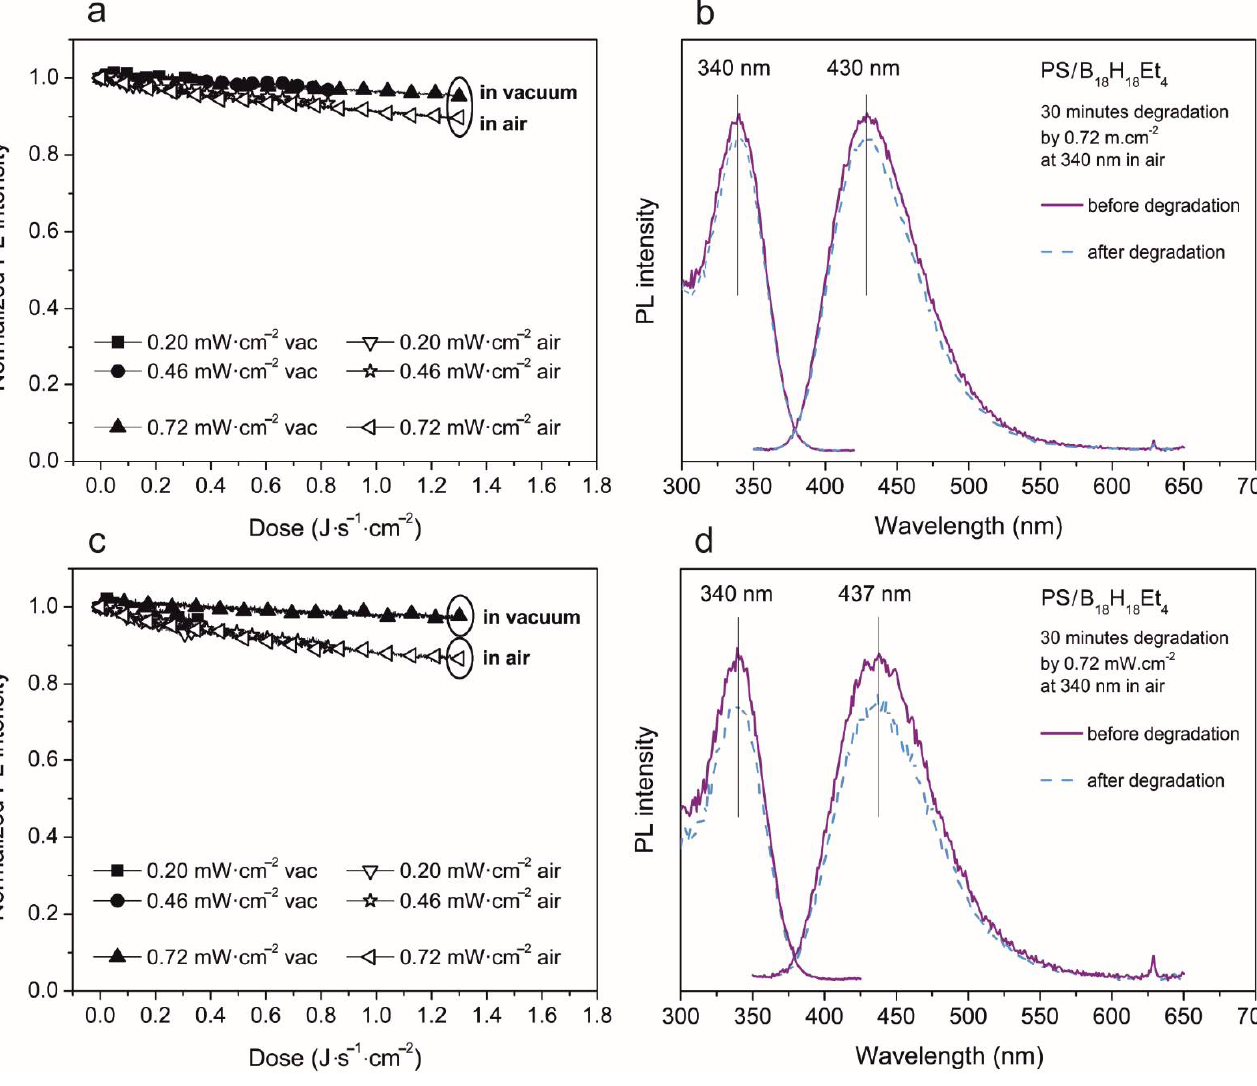
Figure 9. Photodegradation study of 750 nm ( a , b ) and 200 nm ( c , d ) thick film of PS/3,3′,4,4′-Et 4 - anti -B 18 H 18 in ratio 150:1. Left ( a , c )—evolution of normalized PL intensity of emission maxima in both vacuum and air environment depending on the energy dose. The excitation and emission spectra measured before and after 30 min of degradation—right ( b , d ).